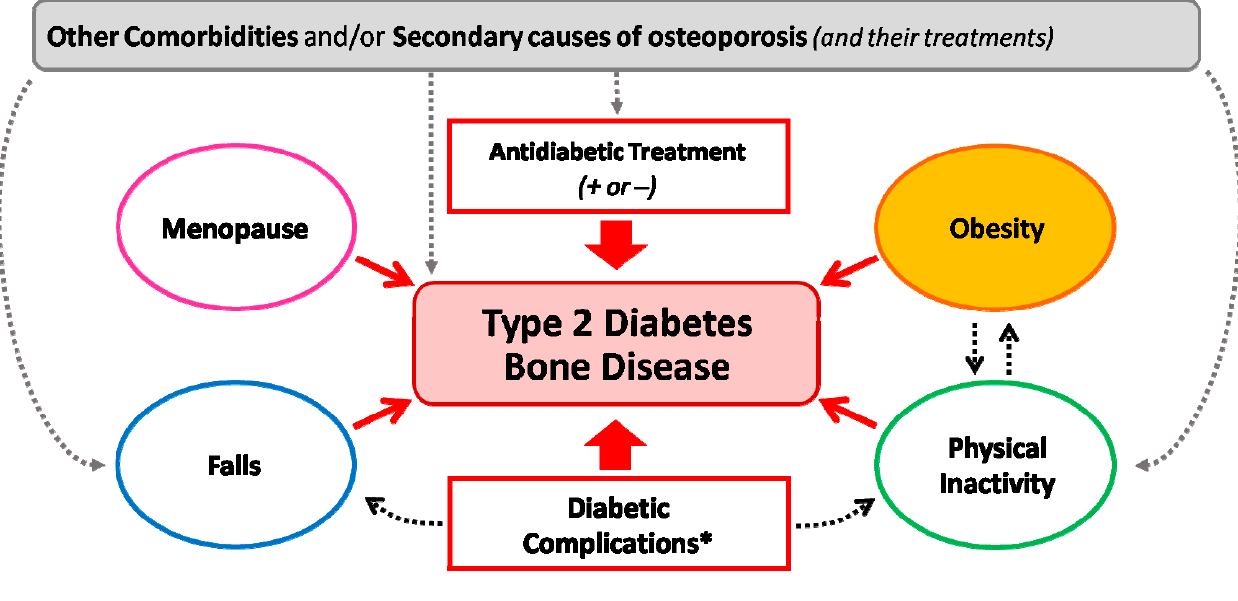
Figure 4. Heterogeneous determinants of bone fragility in type 2 diabetes. The figure underlines the interaction among different conditions interacting with type-2-diabetes-induced bone fragility on enhancing the risk of fractures in different patient settings.